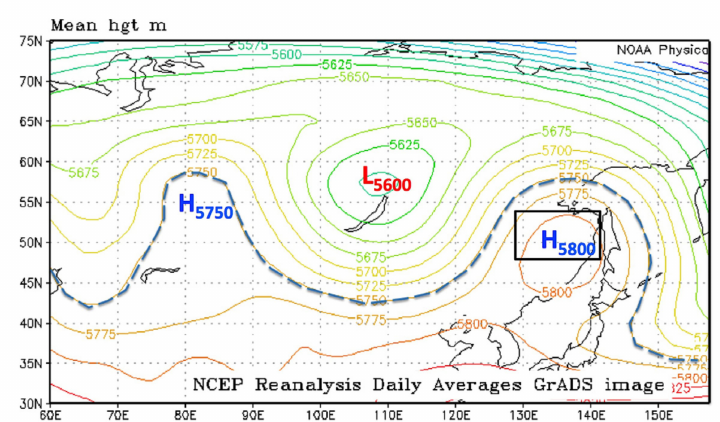
Figure 13. Averaged weather chart from 24–29 June 2012 for the upper-level (500 hPa) during the June fire-period in